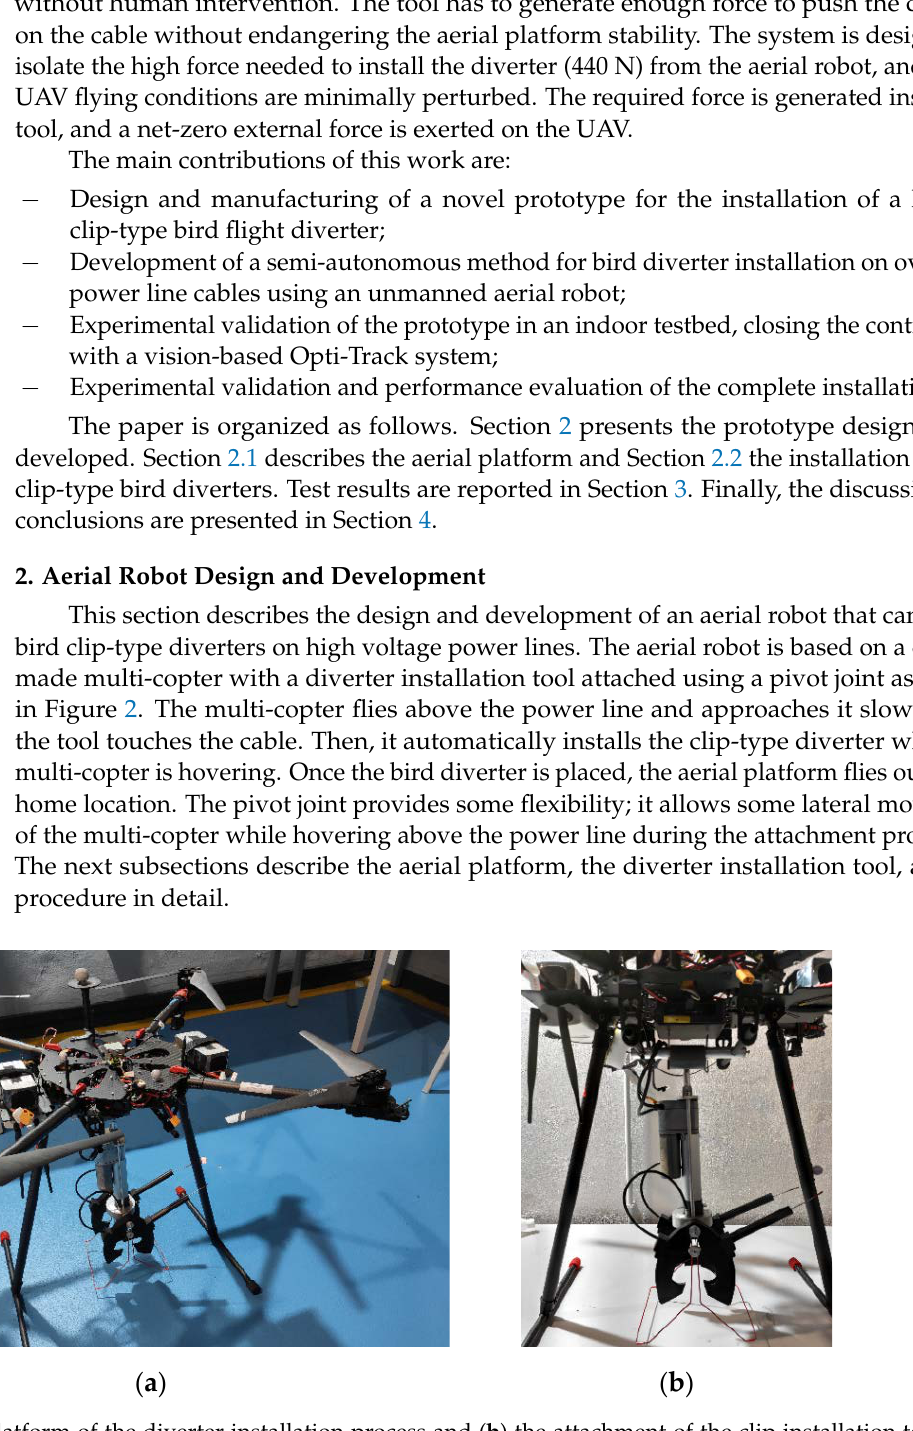
Figure 2. ( a ) The aerial platform of the diverter installation process and ( b ) the attachment of the clip installation tool through a pivot joint.